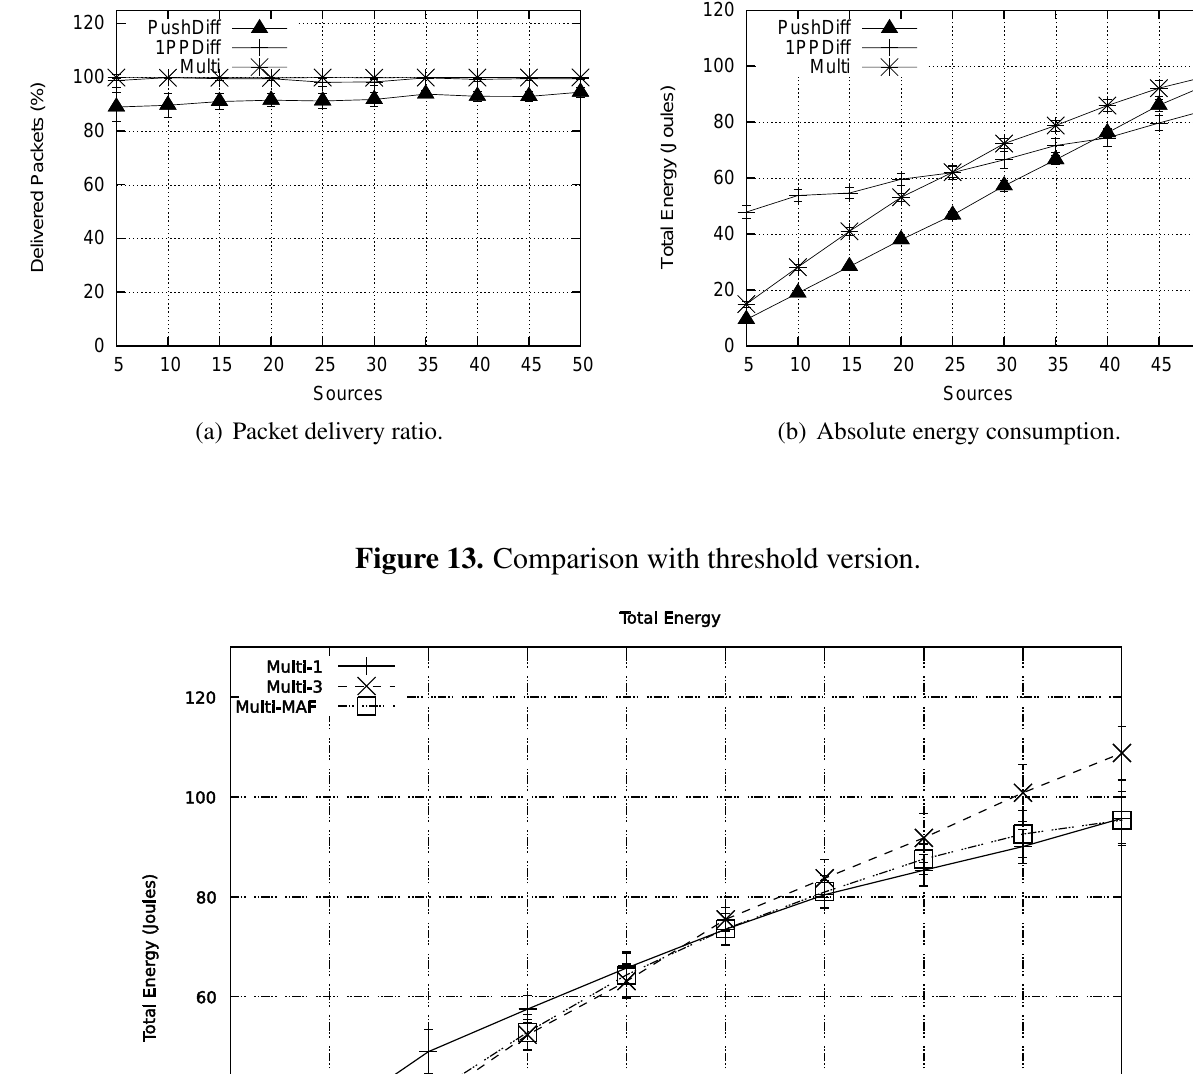
Figure 12. Comparison with Diffusion versions in the uncorrelated detection scenario.